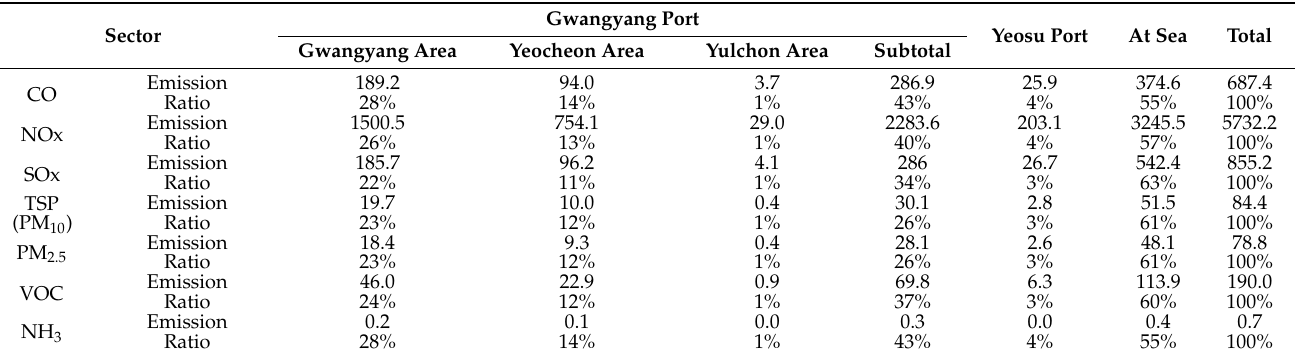
Table 5. Air pollutant emissions by port